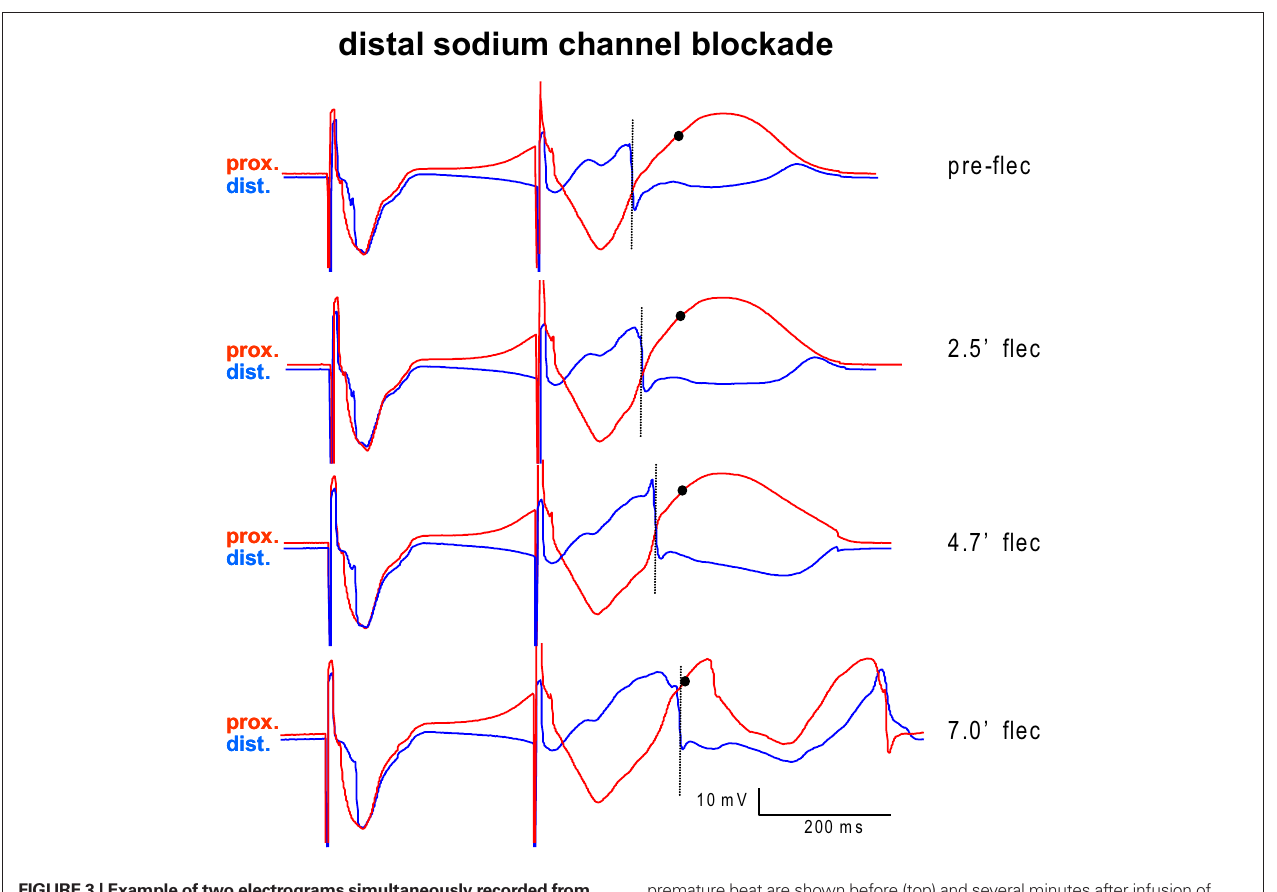
Figure 3 | example of two electrograms simultaneously recorded from the myocardium proximal (red) and distal (blue) from the interface between the perfusion beds. Proximal tissue was perfused with pinacidil, distal tissue was perfused with sotalol. The last basic beat and the first